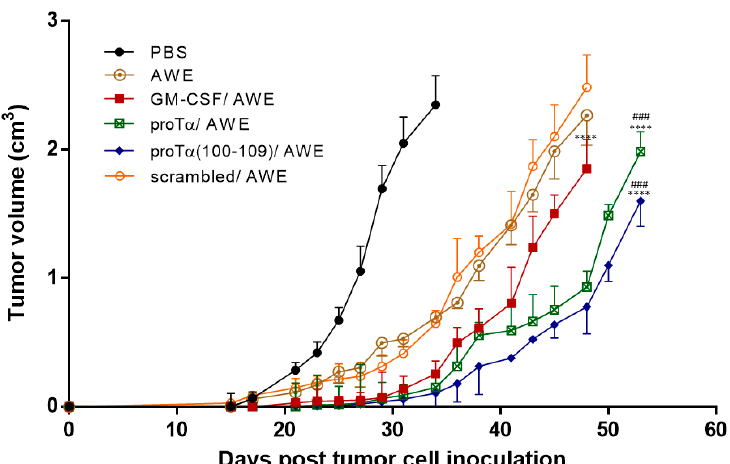
Figure 2. E ff ect of proT α and proT α (100–109) on melanoma tumors in vivo. Mice were s.c. inoculated with B16.F1 cells (day 0) and, upon palpable tumor formation (day 15), i.p. treated with PBS (control; black curve) or AWE alone (brown), in conjunction with GM-CSF (red), proT α (green), proT α (100–109) (blue), or scrambled peptide (orange curve). For protocol details, see Figure 1. Tumor growth was monitored for up to 54 days. Mean tumor volumes ± SD from 8–10 mice / group are shown. **** p < 0.0001 compared to AWE; ### p < 0.001 compared to GM-CSF/AWE.